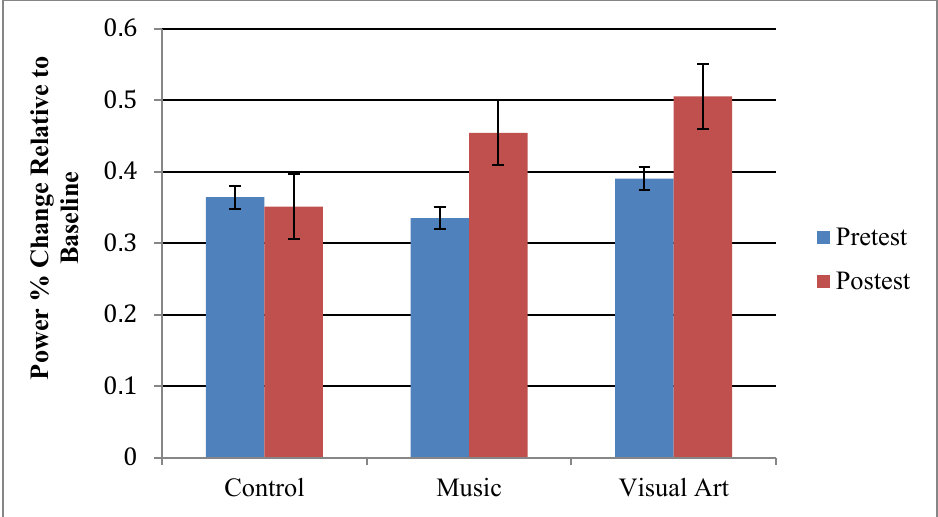
Figure 4. Group mean theta power elicited by the standard stimuli during pre ‐ training (Session 1) and post ‐ training (Session 2).